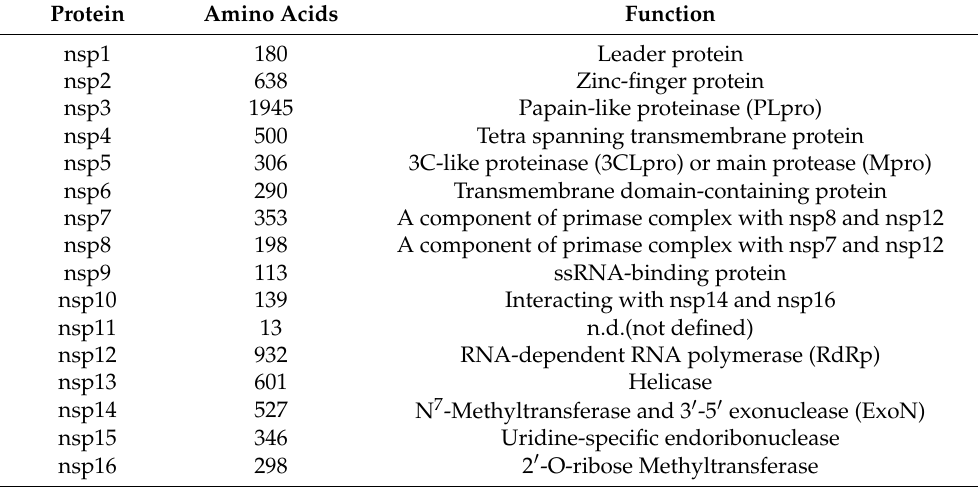
Table 1. The basic description of the nonstructural proteins based on annotation of the GenBank ID